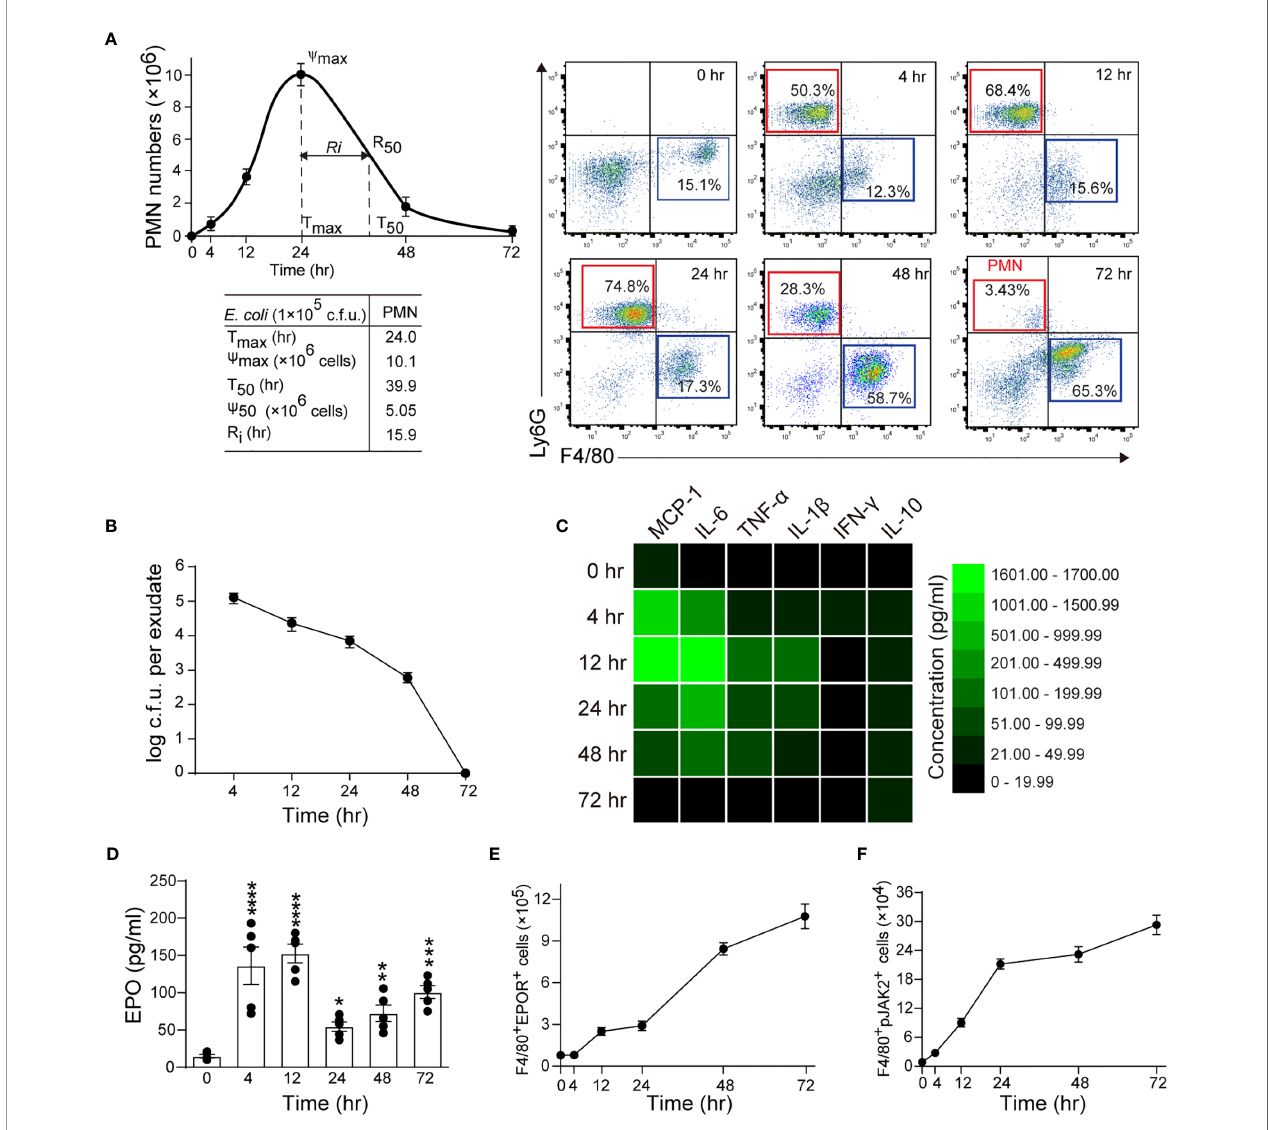
FIGURE 1 | Macrophage EPO signaling is temporally activated in self-limited E. coli -initiated infections. Mice were inoculated with E . coli at 1 × 10 5 c.f.u. by intraperitoneal injection (n = 5 for each time point). (A) : Left panel: time course of peritoneal PMN numbers and resolution indices (n = 5). Right panel: representative fl ow cytometric dot plots of peritoneal leukocytes. (B) : Time course of bacterial titers in peritoneal lavage fl uids (n = 5). (C) : Heatmap of peritoneal in fl ammatory cytokines (n = 3), see histogram in Figure S1C . (D – F) : Time course of EPO concentrations in peritoneal lavage fl uids (D) , peritoneal exudates of F4/80 + EPOR + macrophages (E), and peritoneal exudates of F4/80 + pJak2 + macrophages (F) (n = 5). Data are representative of at least two independent experiments. Results were expressed as mean ± SEM. * P < 0.05, ** P < 0.01, *** P < 0.001 and **** P < 0.0001 compared to 0 hrs. Statistics: One-way ANOVA with Tukey ’ s post hoc test for multiple comparisons (D)